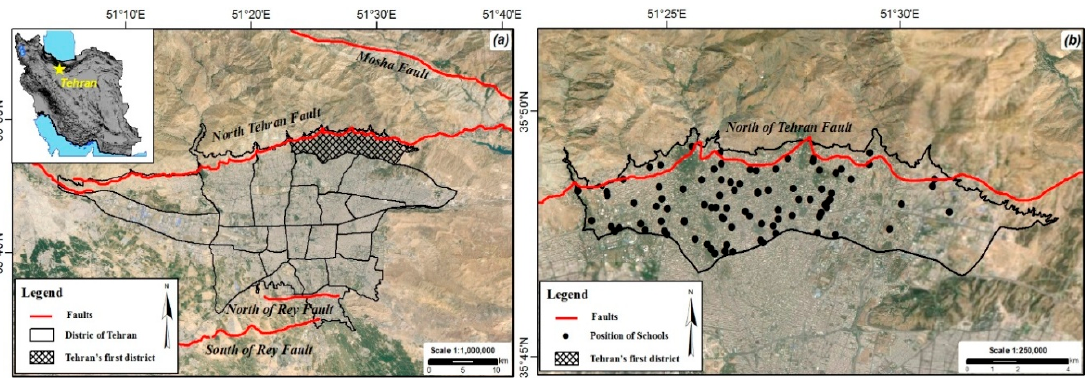
Figure 1. The geographical positions of: ( a ) District 1 in Tehran and the adjacent faults, and ( b ) school buildings in District 1.